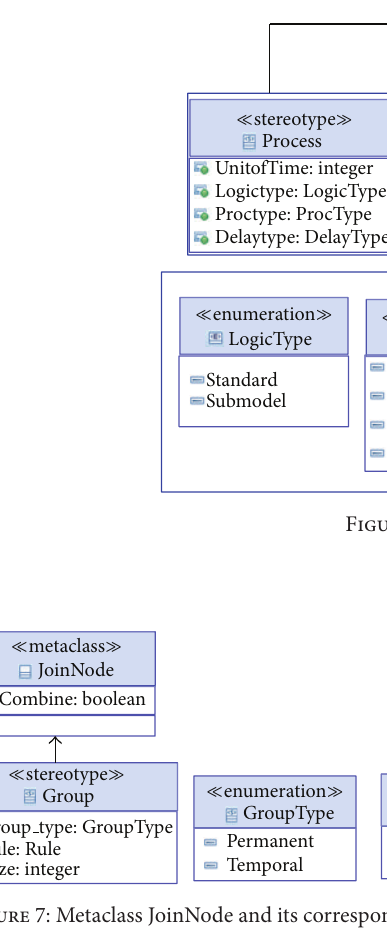
These connectors are represented with the metaclass of the activity diagram named ControlFlow. It is not necessary to extend this base class because there is a bilateral matching of the